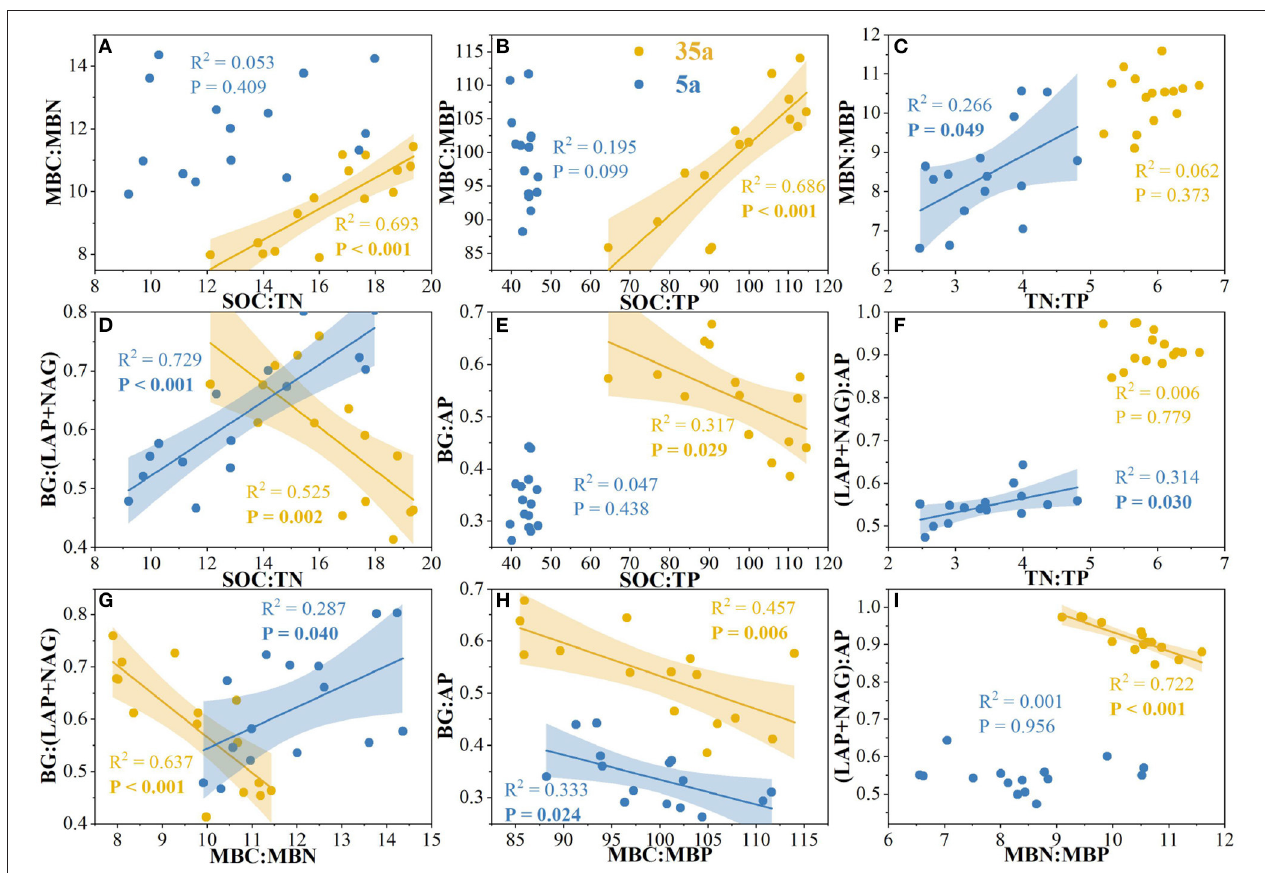
FIGURE 4 | Relationships among soil carbon (C)/nitrogen (N)/phosphorus (P) stoichiometry, microbial biomass C/N/P stoichiometry, and enzymatic C/N/P stoichiometry in 5-year-old (5a, blue) and 35-year-old (35a, yellow) plantations. C acquisition is represented by β -glucosidase (BG); N acquisition is measured by the potential activities of leucine aminopeptidase (LAP) and β -1,4-N-acetylglucosaminidase (NAG); P acquisition is measured as acid phosphatase (AP)